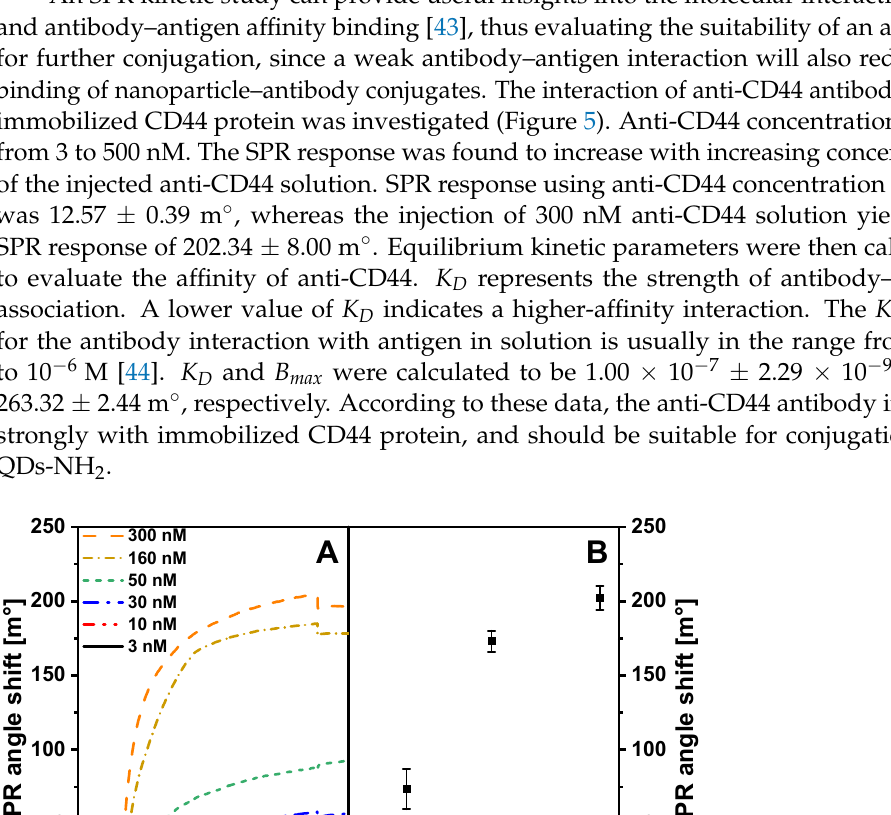
Figure 4. Dependence of Au/CD44/anti-CD44 complex dissociation and surface regeneration efficiency on the nature of the regeneration solution.